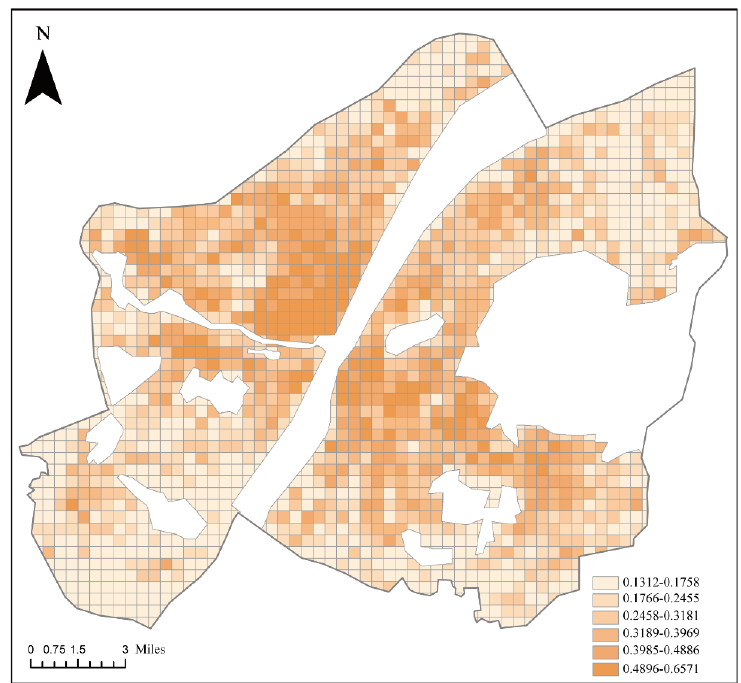
Figure 6. Spatial distribution of fire risk in central Wuhan.